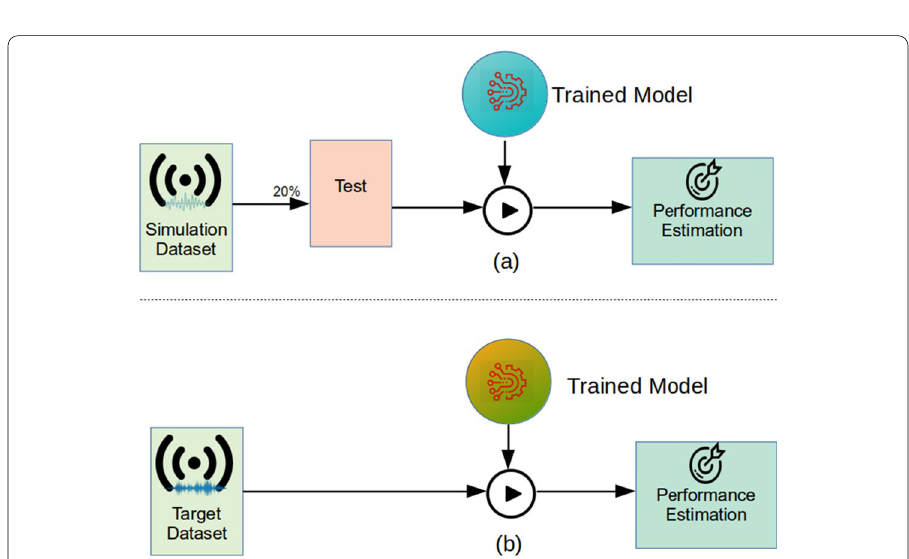
Fig. 9 Estimating model’s error on target